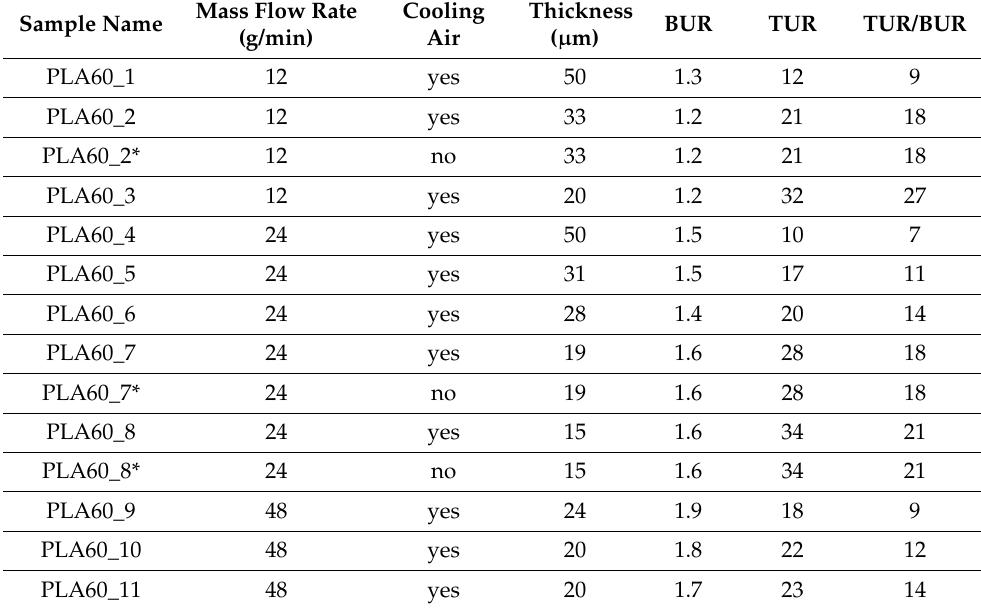
Table 2. Films produced from the blend PLA/PBAT 60/40 + 1 wt % Joncryl with their respective process conditions. Films with an asterisk are those produced without cooling